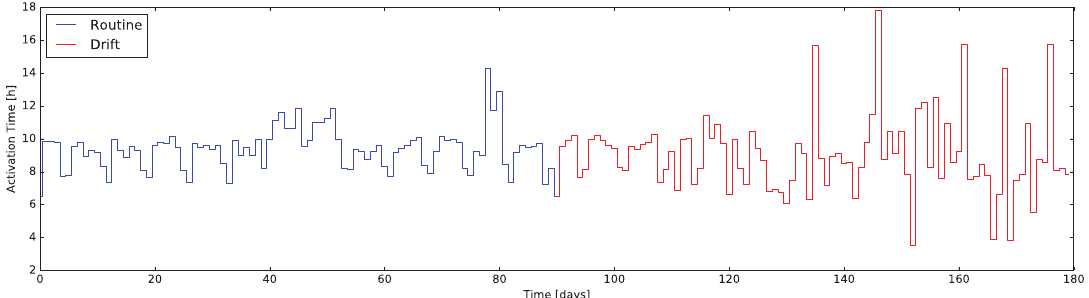
Figure 1. Sensor Activation Time (SAT) indicator: bed activation time. The irregularity introduced in the behavior drift appears as spikes in the indicator value.